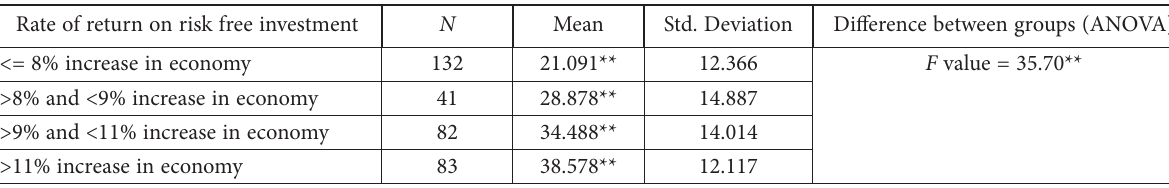
Table 7. Association between the rate of return on risk free investments and the incidence of under-invoicing (source: author’s calculation) Std. Deviation Difference between groups (ANOVA)